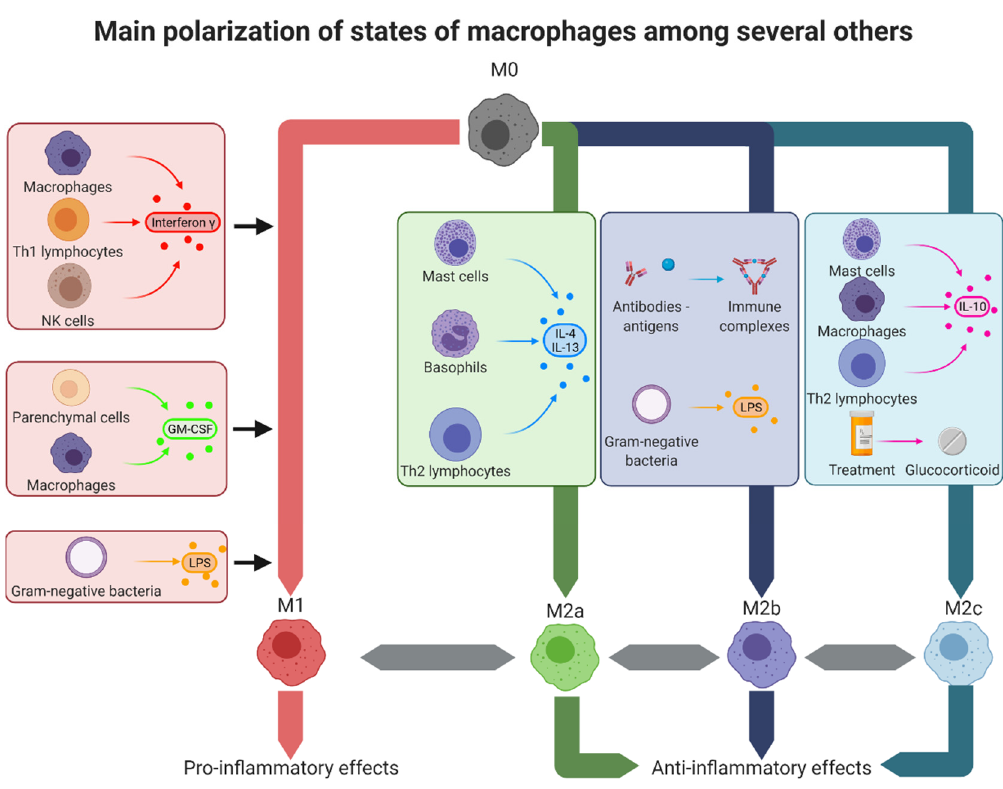
Figure 2. Macrophage polarization states. In the tissues, macrophages can adopt several polarization types corresponding to different activation states. The theoretical extremes of these states are, on one hand, the M1-like macrophages with pro-inflammatory effects, and on the other hand, the M2-like macrophages with anti-inflammatory effects. M1-like macrophages can be obtained by stimulation with interferon- γ , secreted by other M1-like macrophages, Th1 lymphocytes, and NK cells; GM-CSF secreted by M1-like macrophages and parenchymal cells or LPS present on Gram-negative bacteria. M2a alternatively activated macrophages were obtained by stimulation with IL-4 and IL-13 secreted by mast cells, basophils, and Th2 lymphocytes. M2b type II macrophages were obtained after stimulation with immune complexes or LPS. Finally, M2c deactivated macrophages were obtained by stimulation with IL-10 secreted by mast cells, M2-like macrophages, and Th2 lymphocytes or after treatment with glucocorticoids such as dexamethasone. GM-CSF: granulocyte-